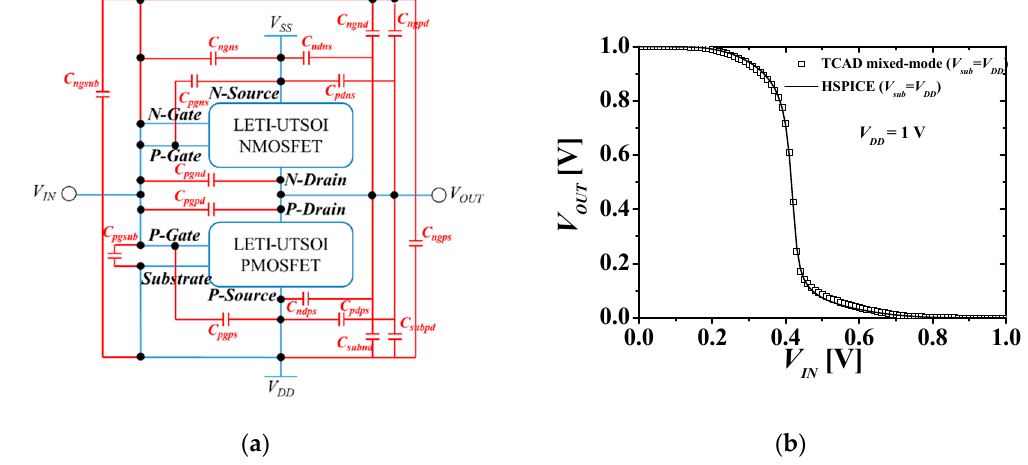
Figure 5. ( a ) Equivalent circuit of M3DINV [14] consisting of internal and external capacitances, where the capacitance caused by monolithic inter-tier vias (MIVs) and metal lines (MLs) are added. ( b ) Voltage transfer characteristics ( VTC) of M3DINV [14]. V SS = 0 V and V DD = 1 V.